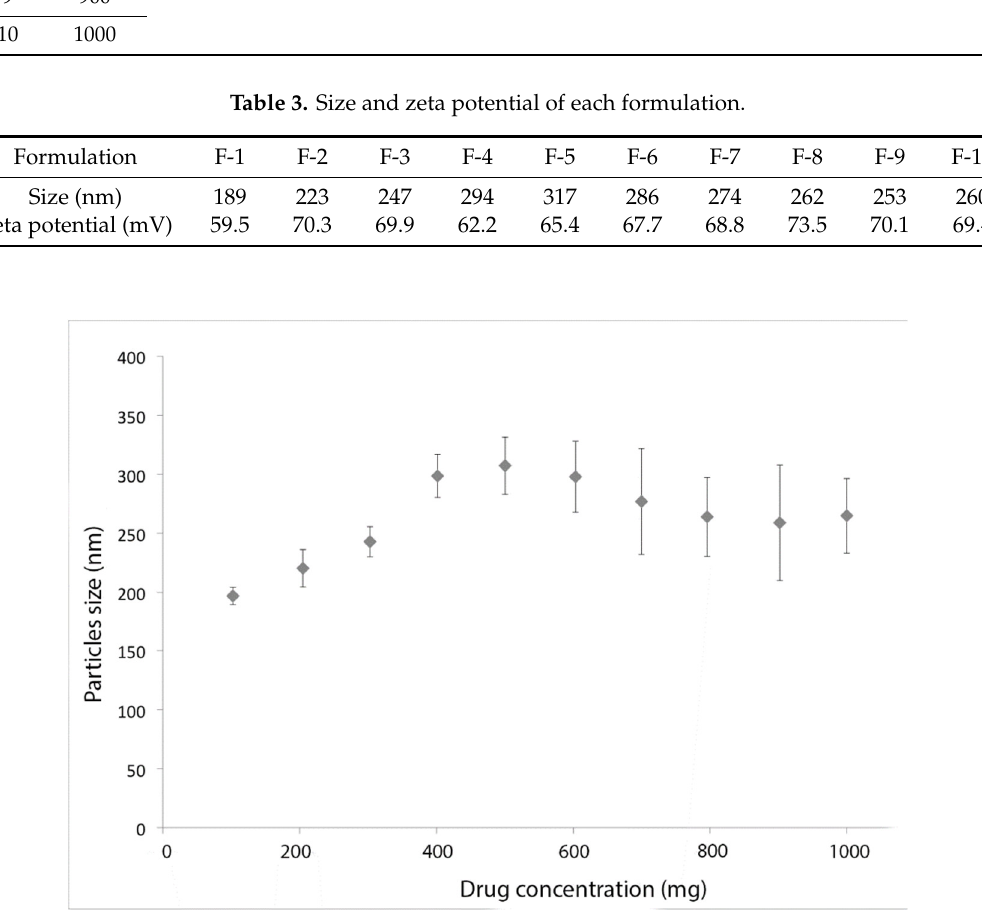
Figure 2. Influence of retinol amount on particle size (d average).